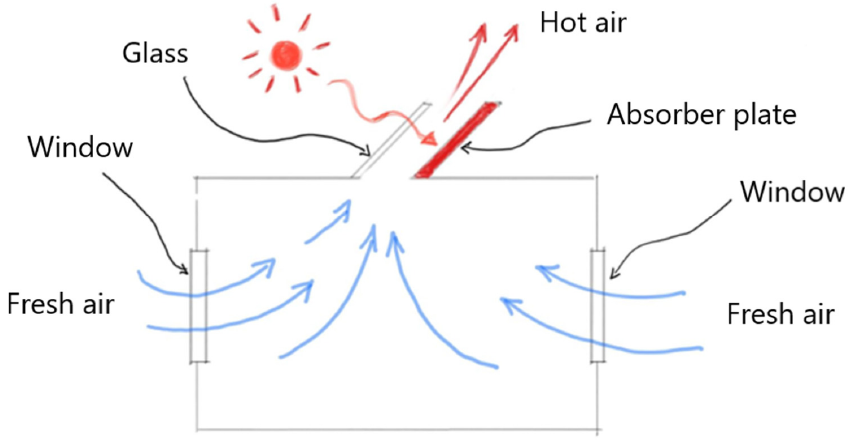
Figure 1. Functioning of a solar chimney .